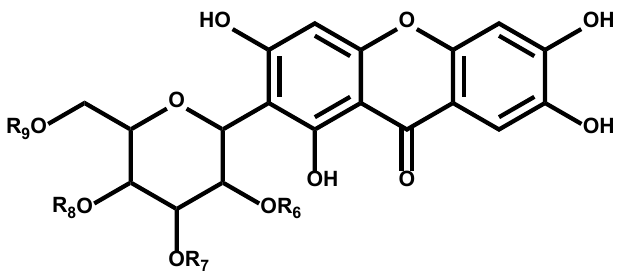
FIGURE 2 – Xathones and flavonoids identified in ethanolic extract from the Fridericia